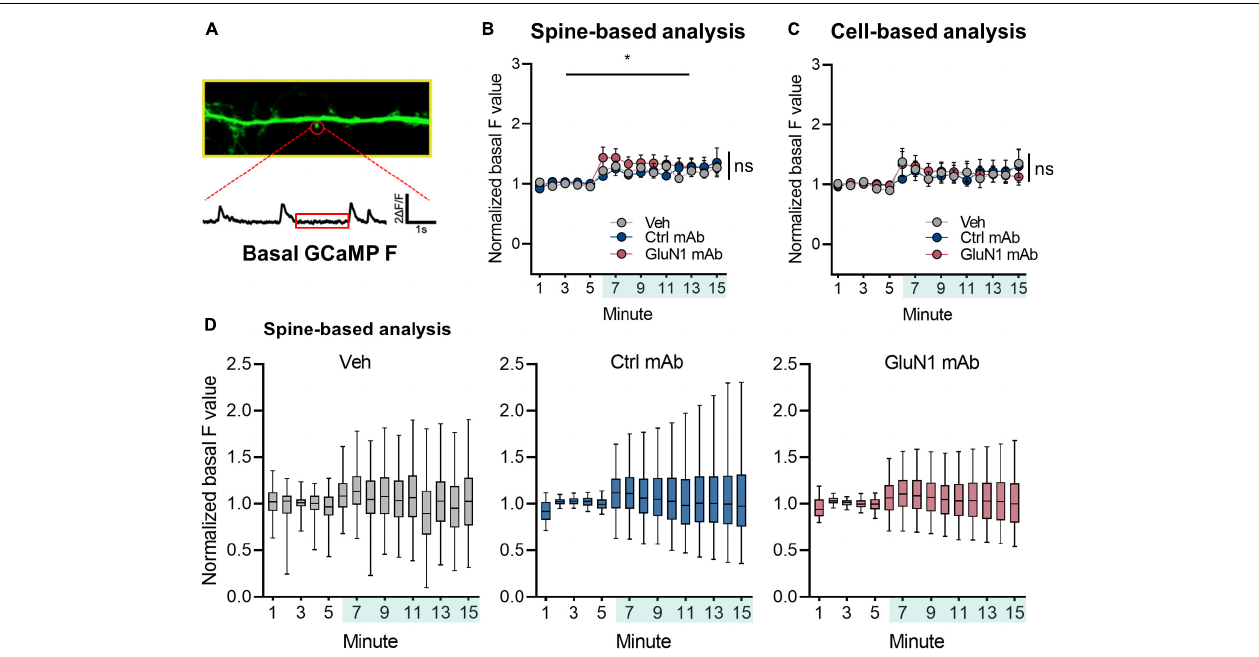
FIGURE 3 | Basal Ca 2 + at synaptic sites is not altered by human GluN1 antibodies. (A) Zoom in of dendrite of hippocampal cell transduced with GCaMP6f (green). Spine identified by red circle. Below, (cid:49) F/F trace of spine region identified in panel (A) plotted against time. Red box indicates region analyzed as basal GCaMP Ca 2 + measurement. (B) Normalized basal F trace of spine over recording session. Vehicle or mAb added after 5 min baseline; teal shaded bar in x-axis represents incubation period. A one-way Welch’s ANOVA was performed to compare the effect of mAb on normalized basal F values in final 5 min between groups. There was an effect of vehicle treatment (1.23 ± 0.076, n = 1,171 spines, p < 0.05, Welch’s t -test comparing baseline to final 5 min). There was no statistically significant difference between groups at final 5 min (control mAb 1.26 ± 0.16, n = 1,151 spines; GluN1 mAb 1.29 ± 0.12, n = 1,705 spines; one-way Welch’s ANOVA [ F (2, 3,182) = 0.07, p = 0.9]. (C) Normalized basal F trace of spines analyzed on per cell basis. No statistically significant difference was observed on F values between treatments at final 5 min (control mAb 1.21 ± 0.46, n = 6 cells; GluN1 mAb 1.16 ± 0.33, n = 6 cells; Veh 1.25 ± 0.51, n = 7 cells; one-way Welch’s ANOVA [ F (2, 10) = 0.06, p = 0.9]. (D) Box plots of normalized basal F values in individual treatments over time. Ctrl, control; mAb, human monoclonal antibody; ns, not significant; Veh, vehicle; * p < 0.05; ns, p >